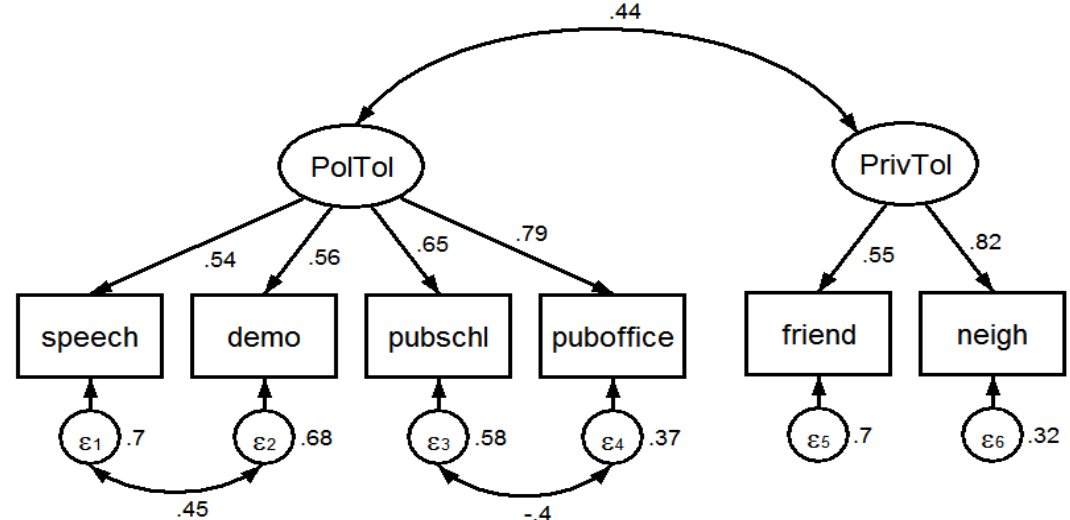
Figure 1: Confirmatory Factor Analysis of Tolerance Variables described above, some individuals are tolerant on political indicators and intolerant on private indicators, while others are intolerant on political indicators and tolerant on private indicators. But the political and the private are not independent dimensions that can be considered apart from each other. Rather they are strongly correlated. Some individuals are generally intolerant on all of the indicators, while others are generally tolerant on all indicators. In short, these are distinct yet related measures of